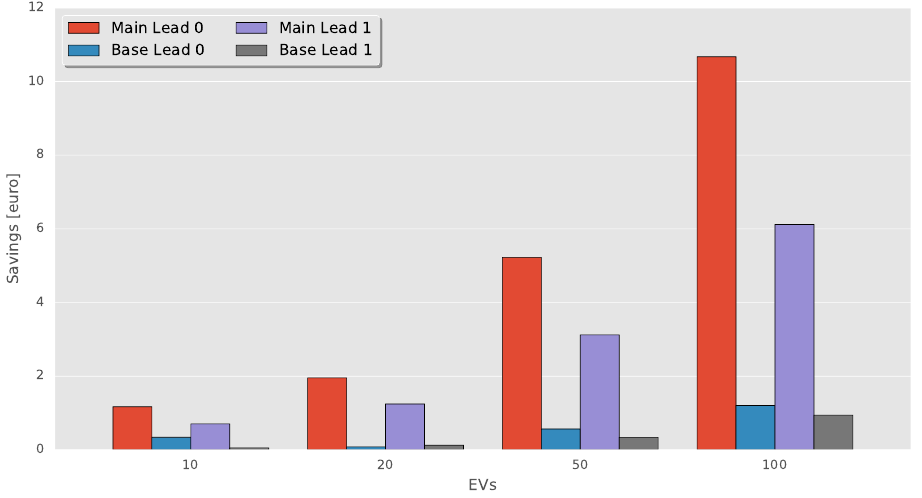
Figure 7. Average daily savings with lead times of 0 and 1 interval(s) compared to a lead time of 2 intervals. The trading unit is set to